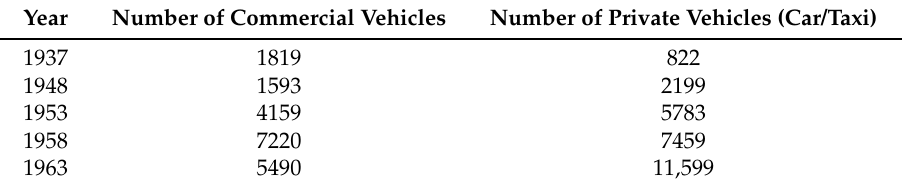
Table 3. Commercial and private vehicle registration in Nigeria across 1937–1963